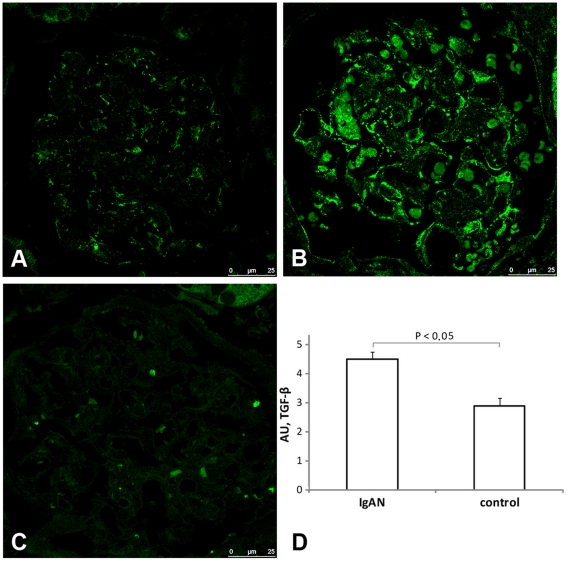
Protein expression of TGF-β in sections from control (A), patient with IgAN (B) and negative control (C).IgAN sections stained significantly stronger for TGF-β, and the average arbitrary unit score for IgAN (n = 83 glomeruli, 4.51±0.25) was higher than control (n = 19 glomeruli, 2.89±0.28) P<0.05 (D). In (B) there is some auto-fluorescence of red blood cells, this phenomenon can also be seen in the negative control, and were not included in the analysis of staining intensity of TGF-β. Magnification ×63.